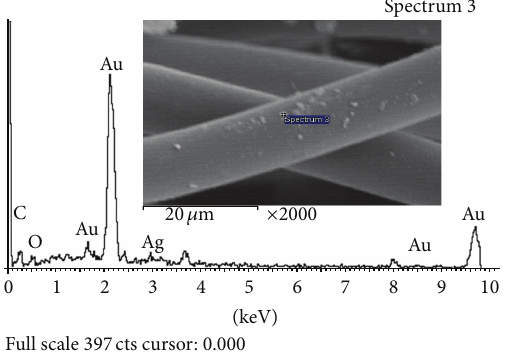
Figure 4: SEM-EDX analysis of fabric after nAg 2 O loading.